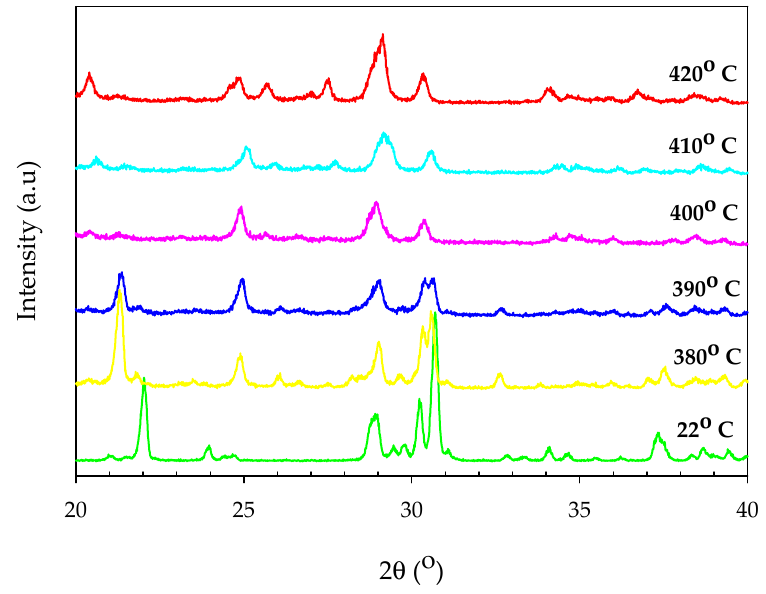
Figure 6. Variable temperature XRD of α -MnNH 4 P 2 O 7 .